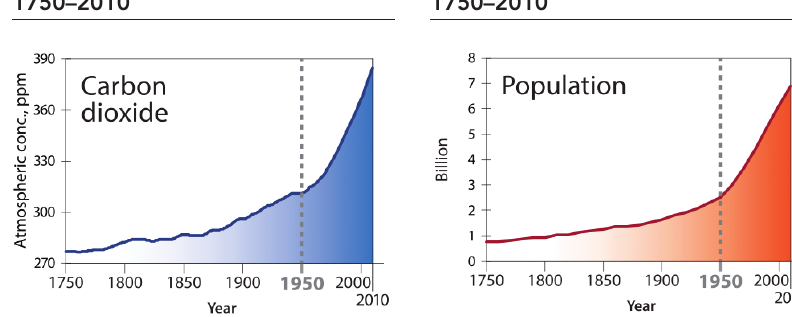
Figure 1: Annual CO2 emissions Figure 2: World